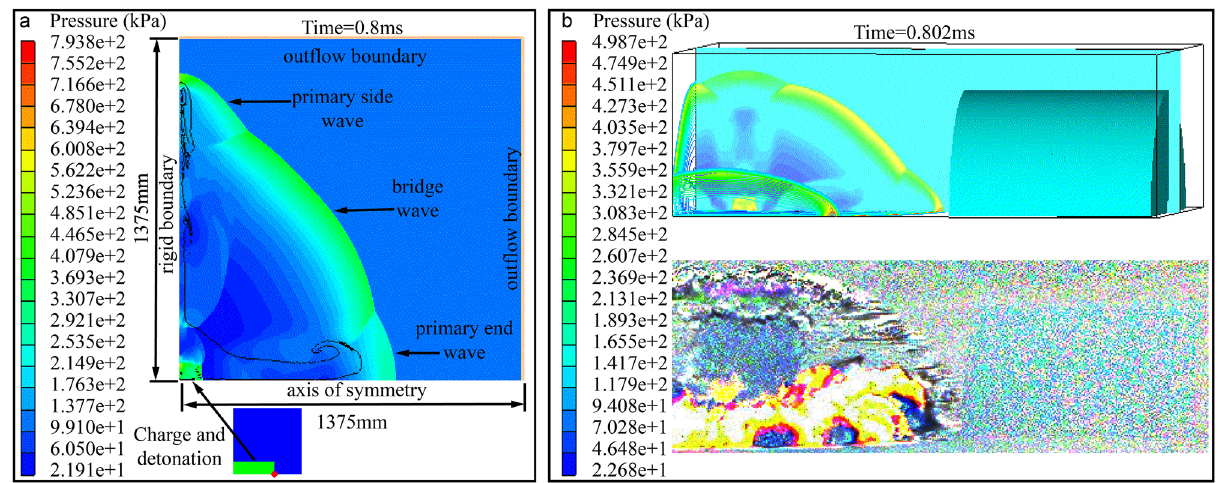
Figure 9. 2D result mapping (adapted from Ref. 15 ). ( a ) The 2D model and simulation results. ( b ) The simulation results of 3D model and test